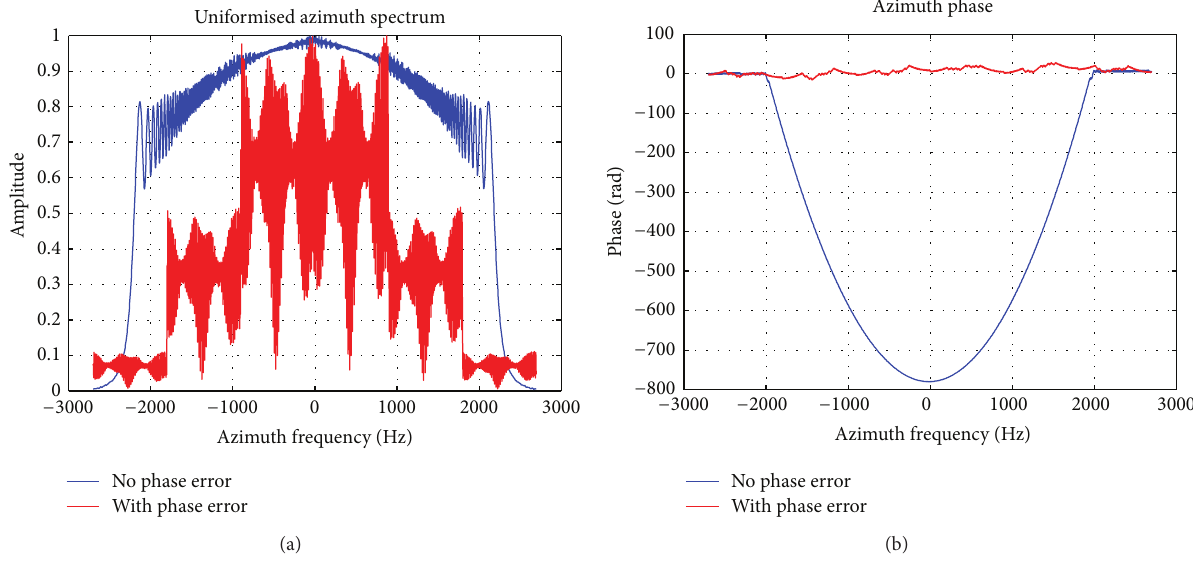
Figure 3: Results of azimuth reconstruction. (a) Azimuth spectrum. (b) Phase.